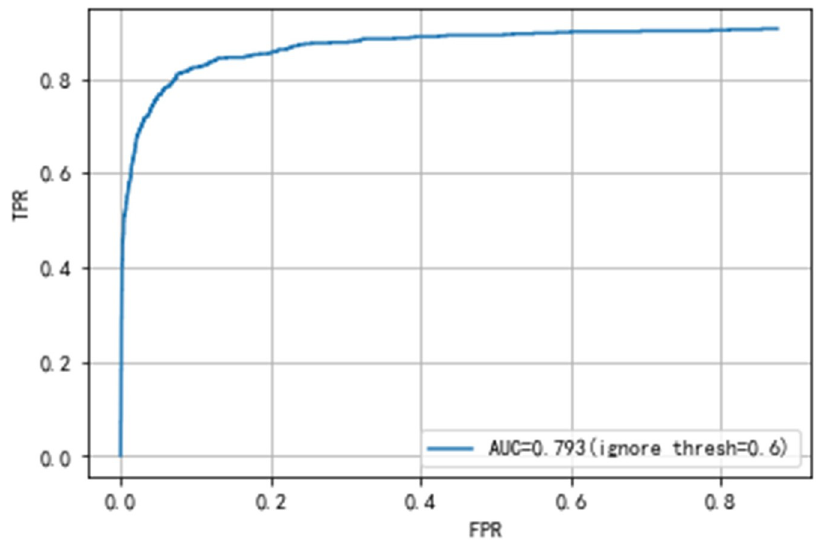
Fig 6. The ROC curve of YOLOv3 and our network.